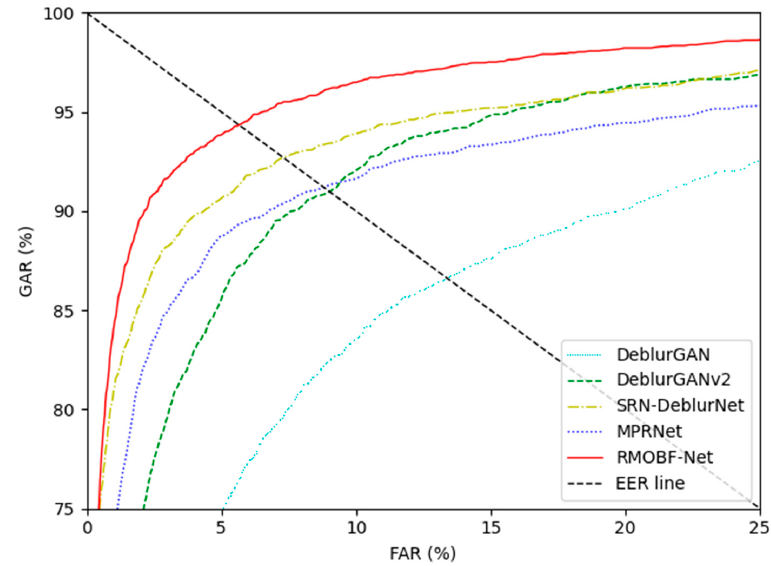
Figure 22. ROC curves of finger-vein recognition with SDU-DB for scheme 5 by various restoration methods (random motion blur and optical blur with intensity 15 × 15 (Gaussian filter size) and 15 (Gaussian filter standard deviation)).